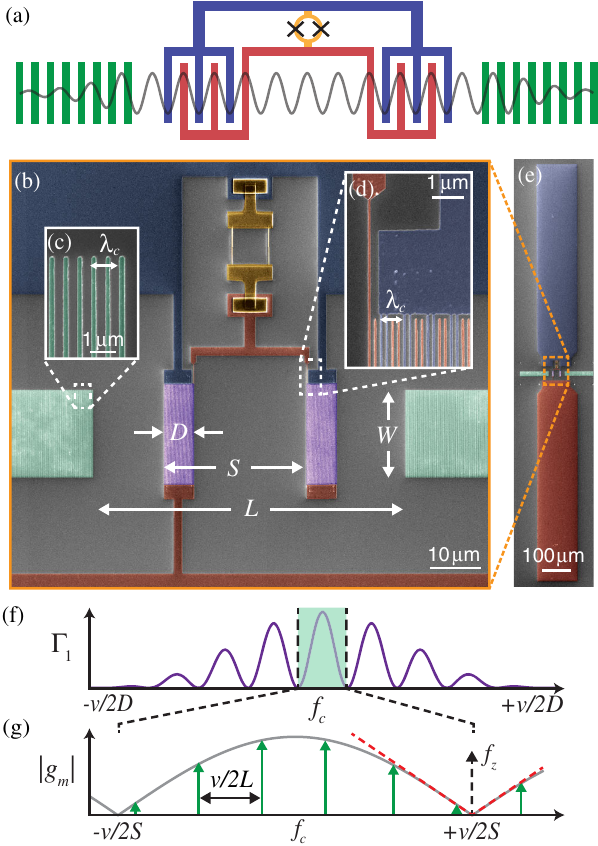
FIG. 1. Double-slit qubit concept and device. (a) Schematic of the device. A transmon qubit resembling a double-slit interfer- ometer is formed by shunting two halves of an interdigitated transducers (IDT, red and blue) with a pair of Josephson junctions (yellow). Two distributed Bragg arrays (green) confine phonons in a narrow frequency band to create acoustic resonances (gray curve). (b) – (e) False-color SEM micrographs of a representative device. (b) The qubit IDT (purple) is shunted by Josephson junctions and located within an acoustic cavity of width W ¼ 16 μ m. The imaged device has half the cavity length of the measured device. Insets show enlarged images (c) of the Bragg mirror and (d) the IDT, whose innermost fingers are extended to shunt the junctions. (e) Antenna paddles couple the qubit to a copper waveguide cavity at 5.9 GHz for readout and control. (f) When the qubit is tuned outside the mirror bandwidth (unshaded), the IDT launches phonons with a frequency depend- ence determined by the Fourier transform of the IDT geometry, creating fringes in the qubit loss rate Γ 1 . (g) Inside the mirror band, the IDT modifies the qubit coupling strength g to the m evenly spaced cavity modes. By tuning the qubit frequency to a zero in the coupling at f , coupling rates exceeding the mode z spacing can be achieved with dispersive operation, provided the slope near f (red dotted line) is much smaller than z